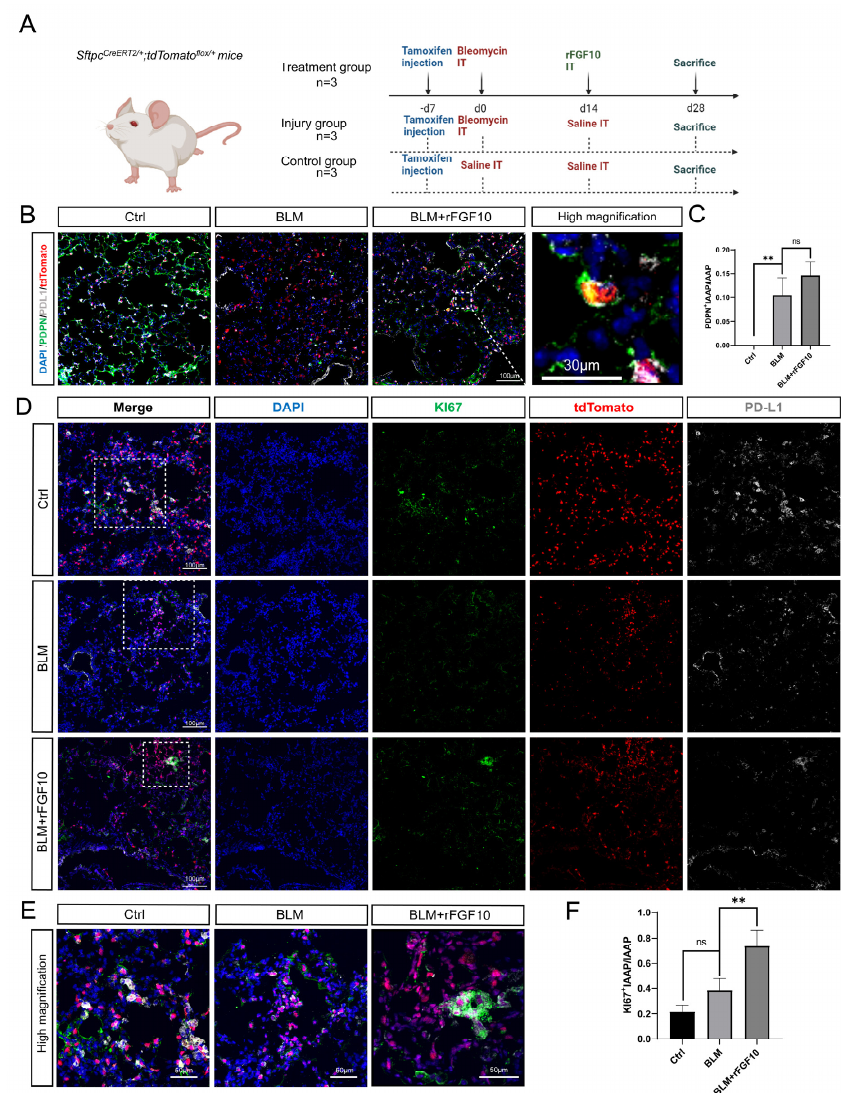
Figure 2. rFGF10 promotes alveolar epithelial progenitor cell proliferation and alveolar repair. ( A ) Timeline of tamoxifen, BLM and rFGF10 treatment of Sftpc Pos lineage-labeled mice. BLM was ad- ministered in 2-month-old Sftpc CreERT2/+ ; tdTomato flox/+ mice ( n = 3). rFGF10 was administered 14 days after BLM administration in the treatment group ( n = 3). Control mice were administered saline ( n = 3). These mice were sacrificed at 28 dpi of BLM or saline administration (designated as Day 0). ( B ) Immunostaining of control, BLM, and BLM + rFGF10 groups of mouse lungs for PDPN (green) and PD-L1 (grey) at 28 dpi of BLM injury. ( C ) Quantification and ratio of PDPN + IAAPs in total IAAP cells. ( D ) Immunostaining of lung sections from mice for KI67 (green) and PD-L1 (grey) at 28 dpi.